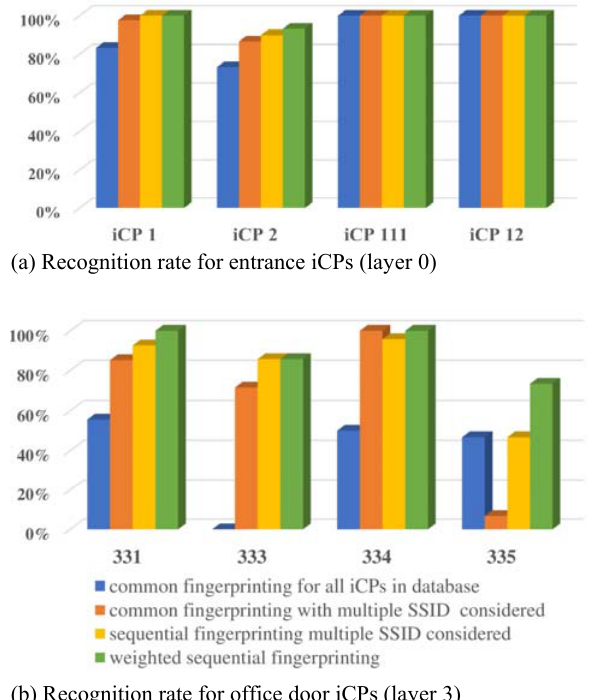
Figure 5. Recognition rates for entrance iCPs (a) and for office iCPs (b) with several fingerprinting strategies